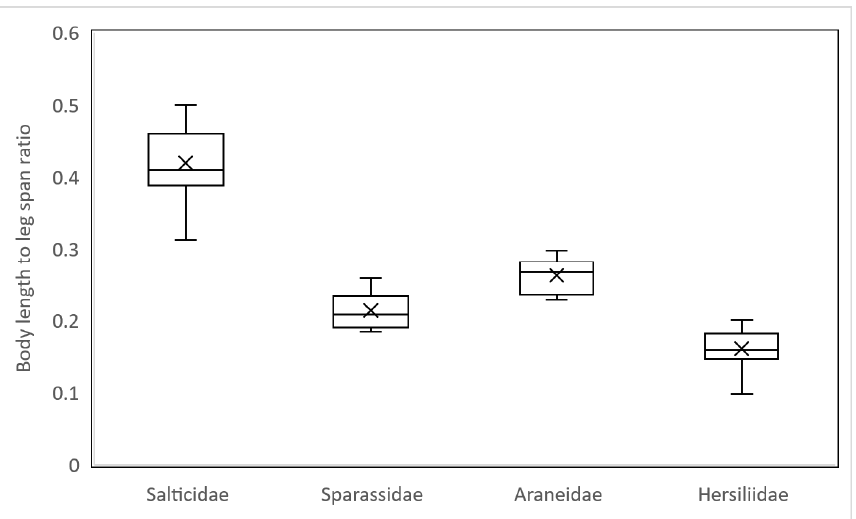
Figure 3. Body length to leg span ratio across four spider families found in mud nests of Sceliphron formosum (Hersiliidae, n = 20; Araneidae, n = 12, Sparassidae, n = 7; Salticidae, n = 17).